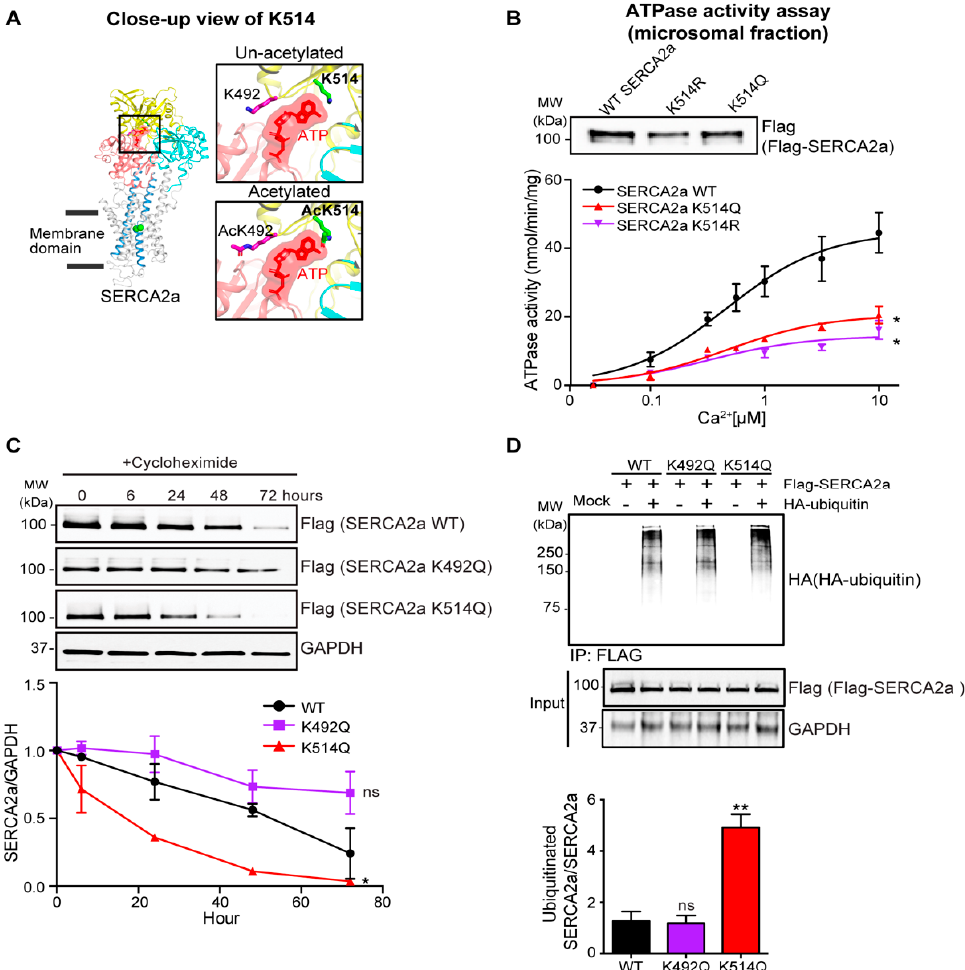
Figure 5. Acetylation on Lys514 diminishes the activity and stability of SERCA2a. ( A ) A structural model of SERCA2a showing Lys492 and Lys514 acetylation sites in SERCA2a. Zoom-in panels show un-acetylated and acetylated forms of the two acetylation sites in the ATP binding pocket of SERCA2a. ( B ) Calcium-dependent ATPase activity of wild-type and acetylation-mimicking mutant forms of SERCA2a. A representative immunoblot of the isolated microsomes containing the different SERCA2a constructs is shown above. Data are represented as the mean ± SD of n = 3 experiments. * p < 0.05 vs. wild-type (WT) SERCA2a by paired t -test. ( C ) Immunoblot is showing a time-dependent experiment of WT, K492Q, and K514Q SERCA2a protein levels following cycloheximide treatment. The quantifi- cation blot is shown below. Graphs show means ± SD of n = 3 experiments. ns, not significant; * p < 0.05 vs. WT SERCA2a by paired t -test. ( D ) Immunoblots are showing in vitro ubiquitination assays of WT, K492Q, and K514Q SERCA2a. The quantification blot is shown below. Graphs show means ± SD of n = 3 experiments. ns, not significant; ** p < 0.01 vs. WT SERCA2a by one-way ANOVA.